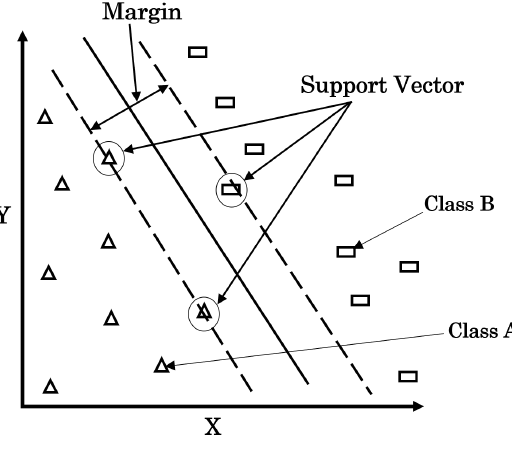
Figure 1. Two classes classification using SVC.